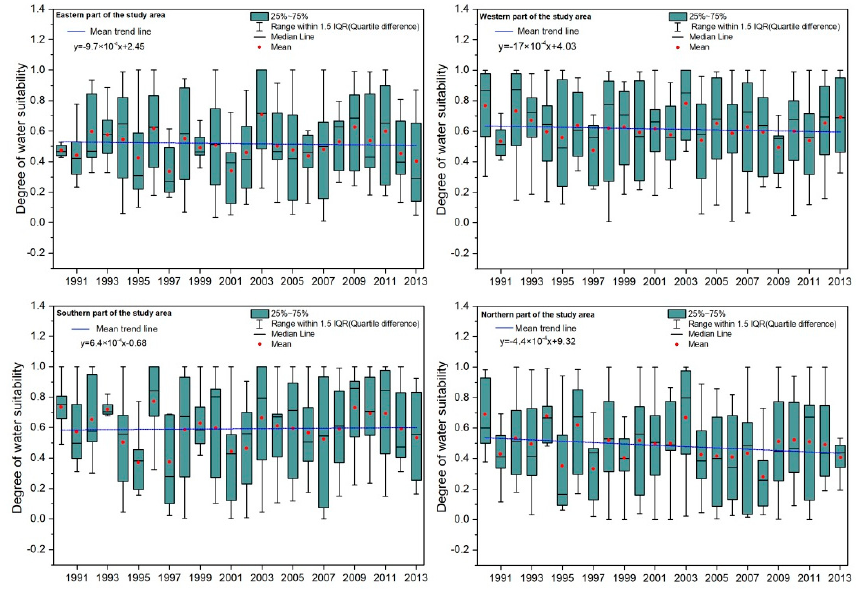
Figure 5. Temporal evolution of water suitability of apple trees from 1990 to 2013.